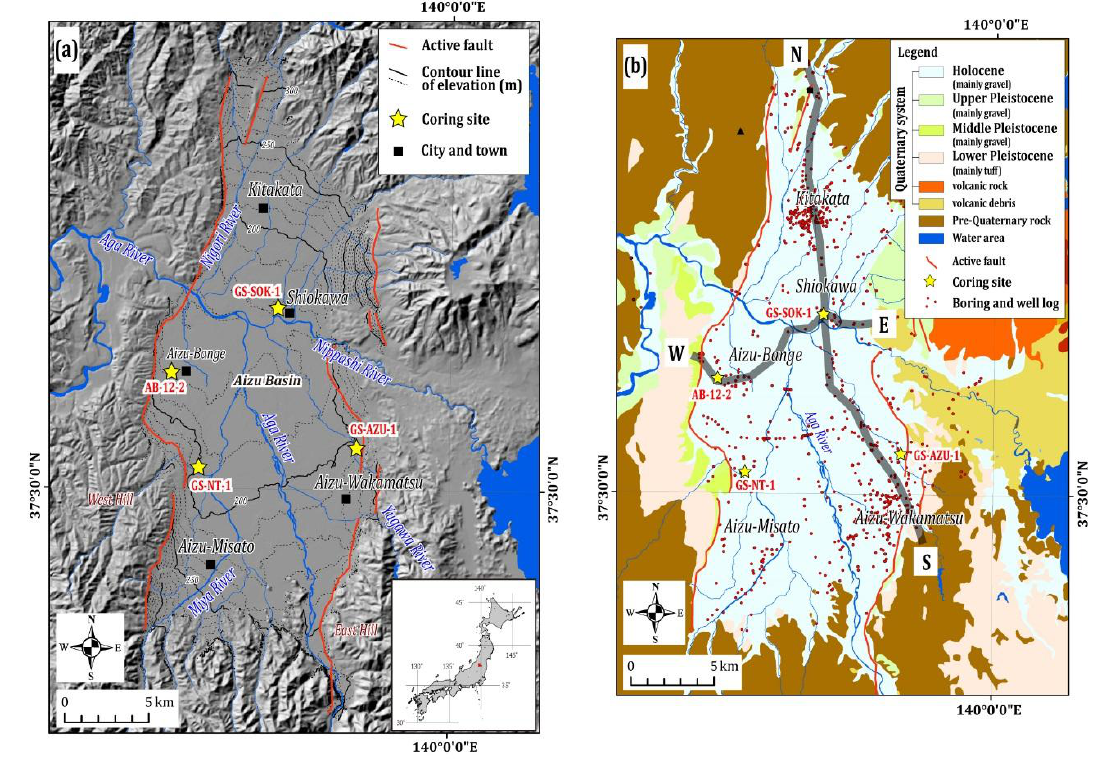
Figure 1. ( a ) Location and geography of the Aizu Basin. Relief map and elevation contour lines are drawn from the 50 m grid digital elevation map of the Geospatial Information Authority of Japan (GSI). The contour line interval is 10 m. The distribution of active faults is after Ikeda et al. [19] ( b ) Geological map of the Aizu Basin modified from the geological survey of Japan [20]. Yellow stars represent drilling sites of sedimentary cores shown in Figure 2. N-S and W-E lines represent the location of cross-sections shown in Figures 3 and